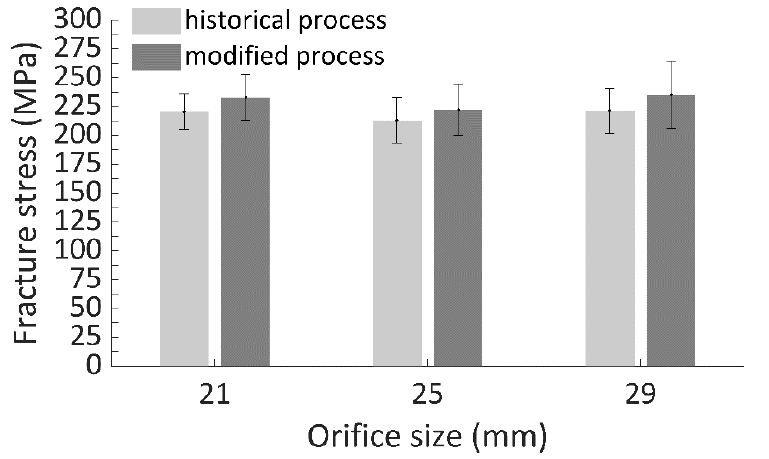
Figure 5. Mean values of Young’s modulus obtained from the three-point bending test for the three different orifice sizes.